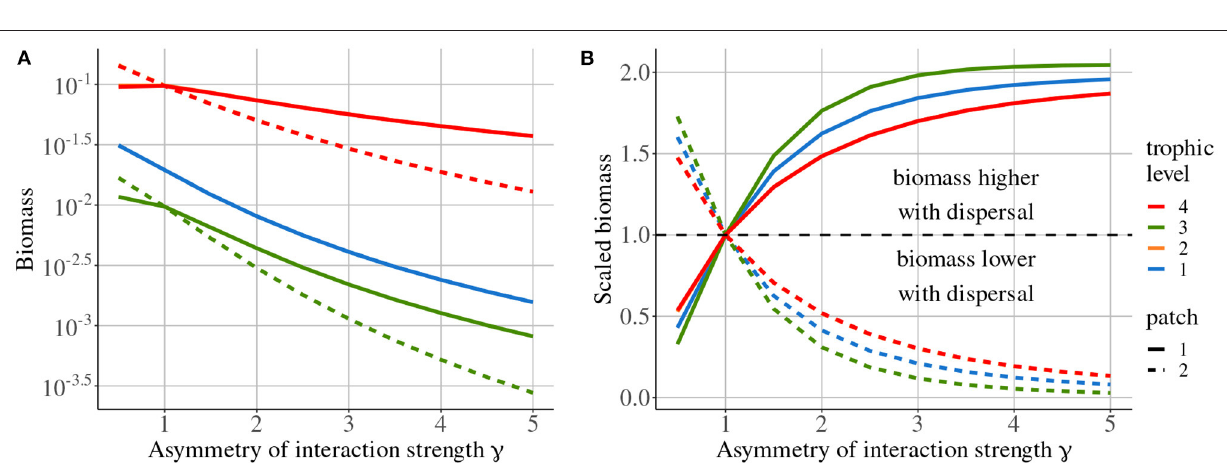
FIGURE 11 | Biomass distribution depending on asymmetry of interaction strength γ . (A) Absolute biomass of each species in each patch. (B) Biomass scaled to the biomass measured in a metacommunity without dispersal. Note that the curves of species 2 are not missing but simply overlap with the curves of species